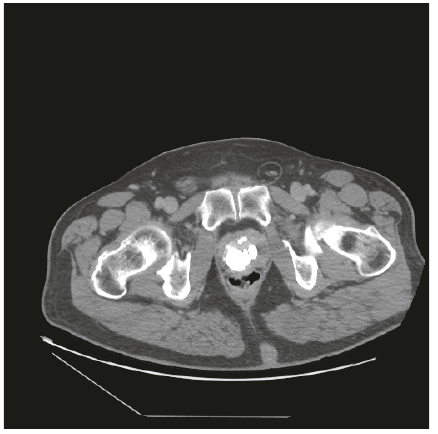
Figure 3: Cystoscopic view from the verumontanum noting a large burden of prostate